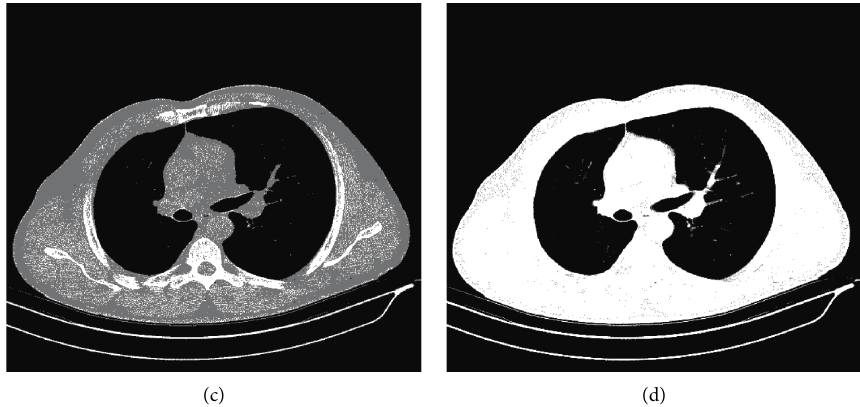
Figure 6: CT image-5 segmentation results of three threshold levels using the proposed approach. (a) Original CT image, (b) level-2 threshold Segmentation, (c) level-3 threshold segmentation, and (d) level-4 threshold segmentation.